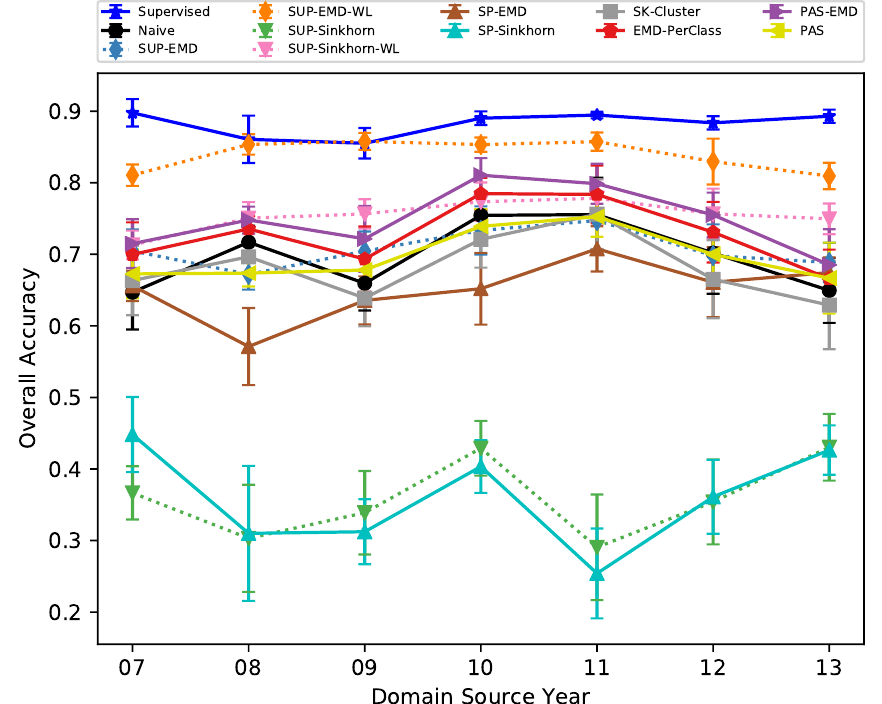
Figure 4. Mean Overall Accuracy for the different methods (y-axis) and the different source domains (x-axis). The nine methods using a unique source domain are represented in this figure, with the supervised, naive and PAS cases for reference. Full curves are methods usable in an operational case, whereas dashed curves represent methods for which the reference data of the target domain are